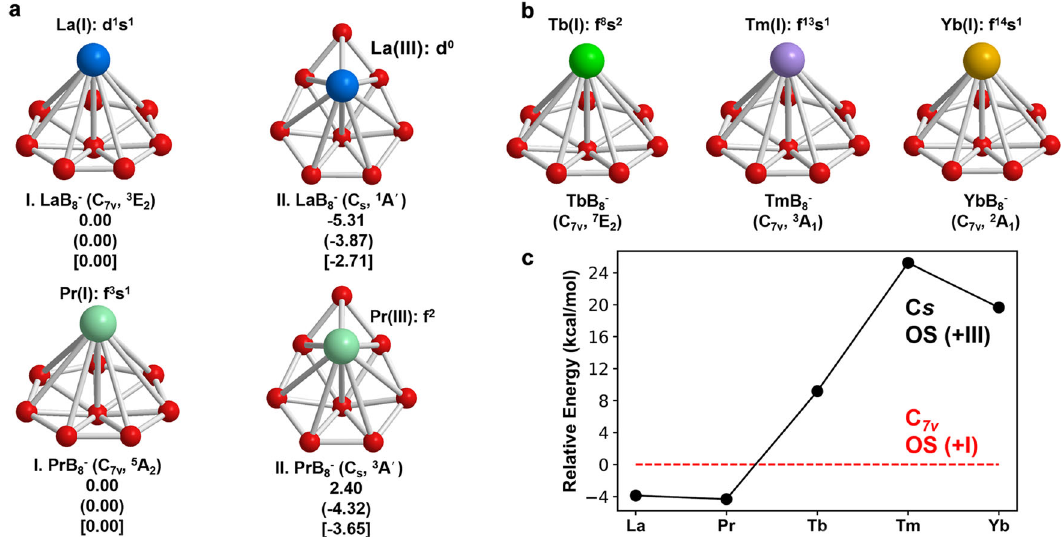
Fig. 2 The structures of LnB 8 − (Ln = La, Pr, Tb, Tm, Yb). a The global minima and low-lying isomers of LaB 8 − and PrB 8 − at the PBE, PBE0 (in parenthesis), CCSD(T) (in bracket) levels, with each corresponding electronic con fi guration. b The global minima of TbB 8 − , TmB 8 − , and YbB 8 − . c The energy difference between the LnB 8 − structures with the + III OS (3D C s structure) and + I OS ( C 7v structure) at the PBE0/TZP level, with the + I OS isomer as the